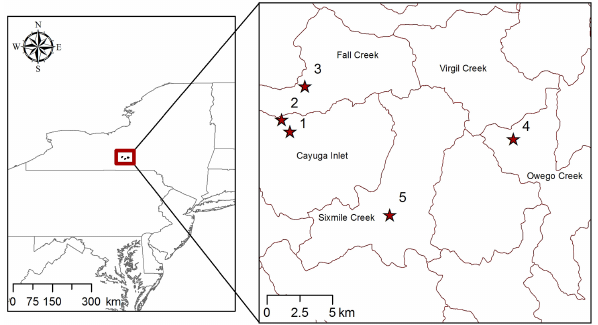
Figure 1. Study site locations (red stars). Watershed boundaries are depicted by red polygons (USGS, 12-digit hydrologic unit